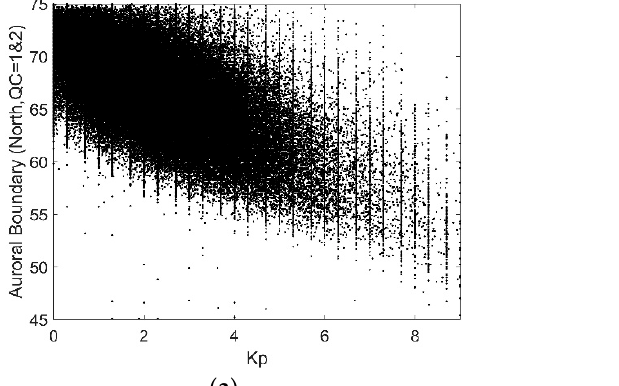
Figure 3. AB in degrees (°) vs. Kp for the northern hemisphere for data with QC = 1 & 2 during the period 1983–2016 considering the original data ( a ) and the daily means ( b ). The linear fit for the daily means ( b ) is in red.